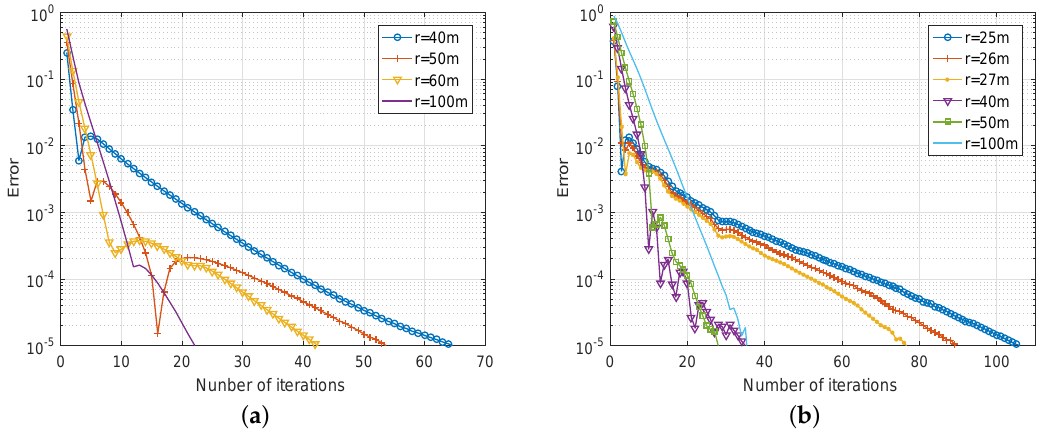
Figure 7. Convergence performances in ( a ) the 10-home system and ( b ) the 100-home system with different communication